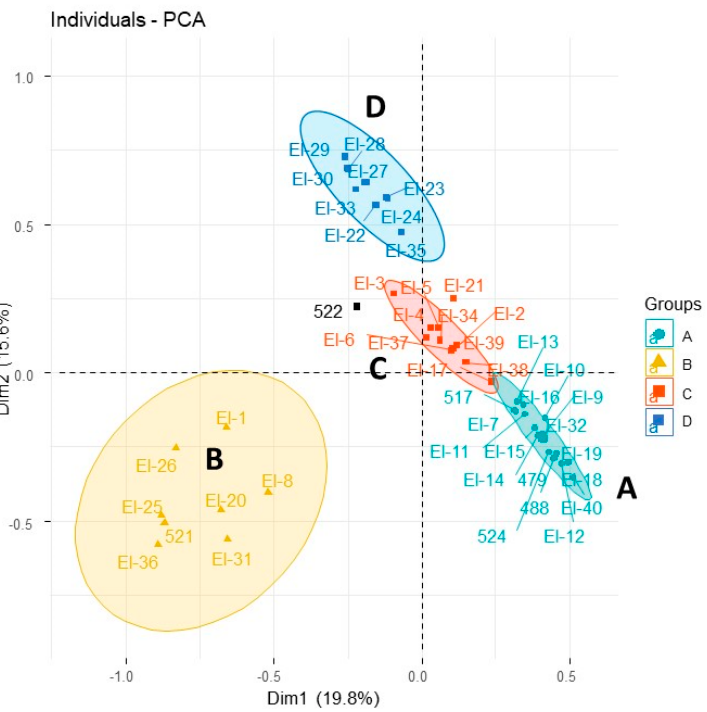
Figure 7. Principal component analysis of essential oil components from Eremophila longifolia